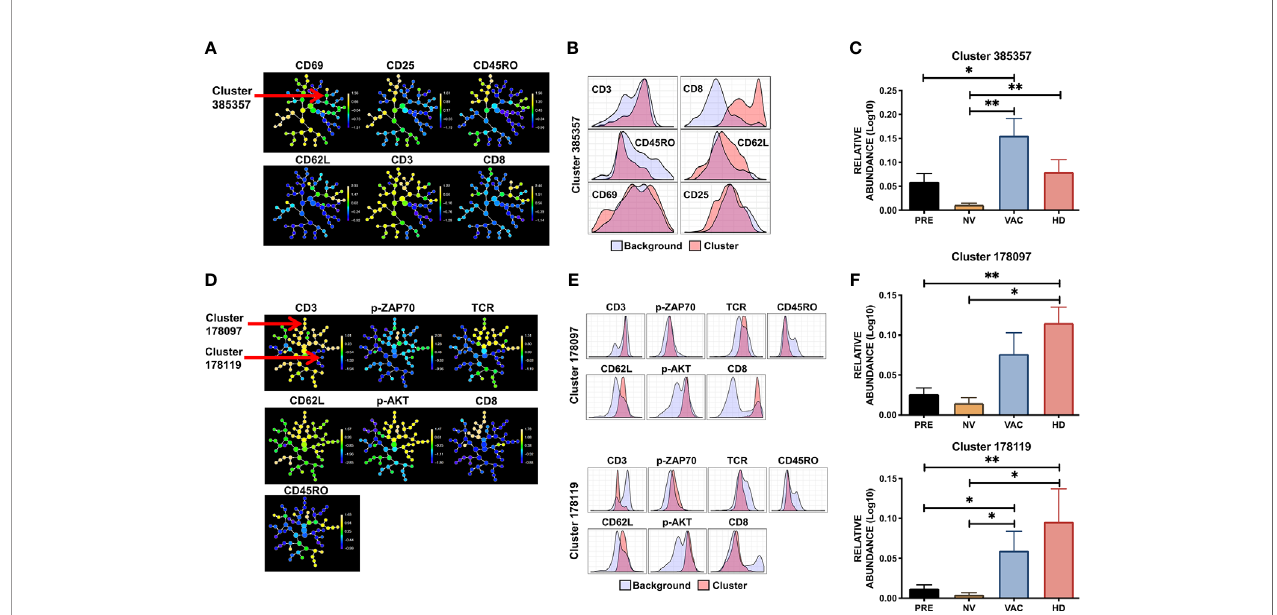
FIGURE 5 | Speci fi c population of T cells are favored by combination therapy NAC + dendritic cells (DCs). CITRUS analysis of peripheral blood mononuclear cell (PBMC) samples obtained from healthy donors (HDs), before chemotherapy (PRE), non-vaccinated (NV), and vaccinated (VAC) patients based on the T-cell receptor (TCR) signaling FC panel. (A) Cluster distribution (hierarchy) and expression level of the corresponding marker from low (blue) to high expression (yellow) for each marker, arrow points at cluster 385357. (B) Histograms depicting the phenotype of cluster 385357 (red histograms) relative to background expression (blue histograms) for each marker (CD3, CD8, CD45RO, CD62L, CD25, and CD69). (C) Relative abundance (Log 10 ) of cluster 385357 in the four groups, patients before chemotherapy (PRE, black bars), post-chemotherapy alone [non-vaccinated (NV), yellow bars], vaccinated patients (VAC, blue bars), HDs (red bars). (D) Cluster hierarchy and expression levels of TCR signaling panel in e x vivo samples, arrows point to clusters 178097 and 178119. (E) Histograms of clusters 178097 and 178119 (red histograms) compared to background expression (blue histograms) in each cluster. (F) Relative expression (Log 10 ) of clusters 178097 and 178119. Non-parametric Mann – Whitney test between populations or groups. *p < 0.05, **p <